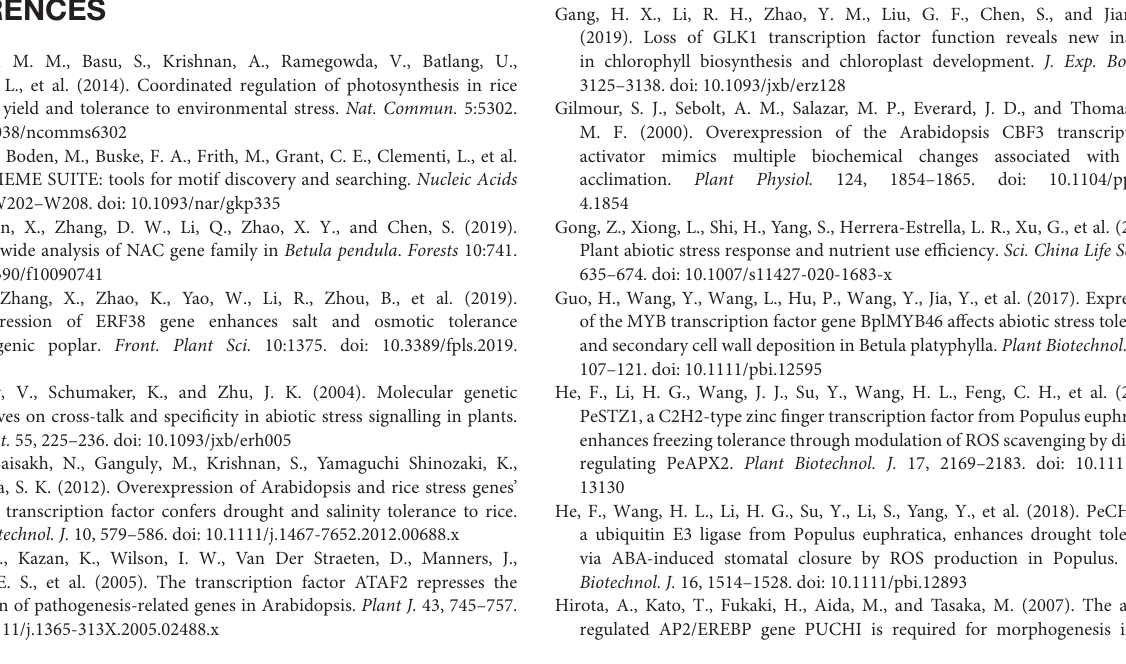
Supplementary Figure 1 | The transgenic lines were verified using PCR and RT-qPCR. (A,B) Respectively represent overexpressed and RNAi lines verified using PCR with primers composed of a forward primer from the promoter of CaMV 35S and a reverse primer from PagERF16. M, DNA marker 2000; WT, wild-type control. (C,D) Shows the relative expression of PagERF16 in OX or RNAi lines. OX-12, OX-16, and OX-19 marked with red tags and RNAi-1, RNAi-4, and RNAi-5 with blue were selected for further analysis. (E) Shoots were sub-cultured on medium without (0mM) or with 50mM NaCl. Bars, 1cm. Supplementary Figure 2 | Identification of differentially expressed TFs coexisted between OX and WT_S. (A) Statistics of DEGs in OX and WT_S compared to WT plants. (B,C) Statistics of TF family of DEGs for WT_S and OX. Supplementary Table 1 | Primer sequences used in this study. Supplementary Table 2 | Statistic analysis of leaf color of OX, RNAi, and WT using LAB methods. 0 < 1 L, white; 0 > 1 L, black; 0 < 1 A, red; 0 > 1 A, green;